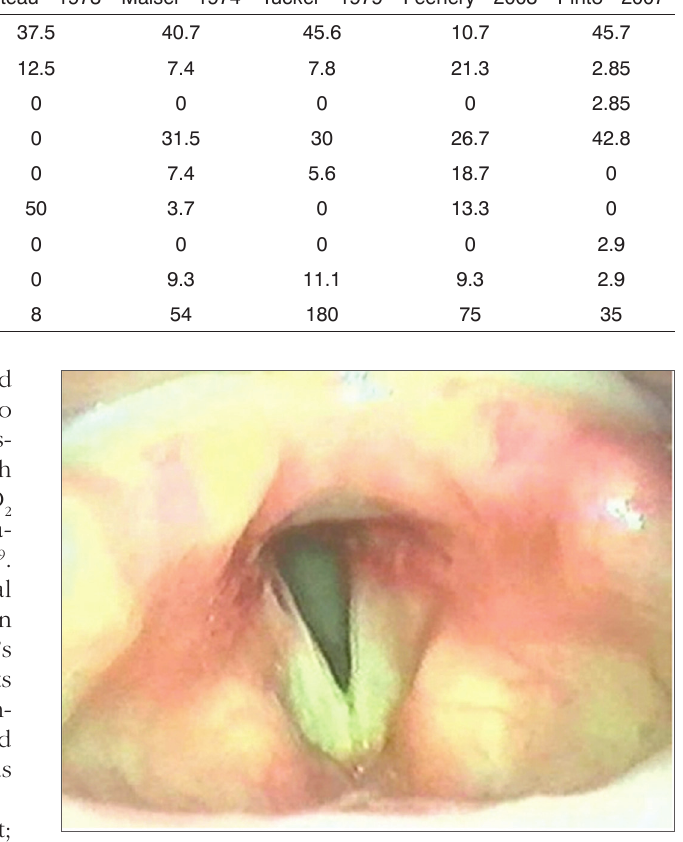
Figure 3. Post-operation – unilateral microtrapdoor